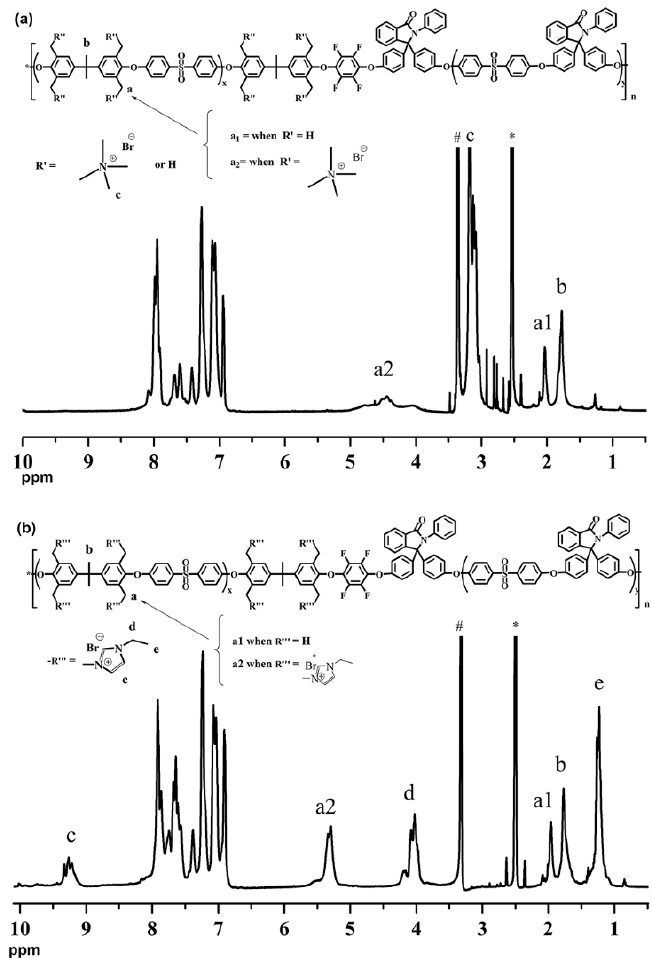
Figure 3. 1 H NMR spectra of ( a ) cardo-PES-QA and ( b ) cardo-PES-IM in DMSO-d 6 at 25 ◦ C. * indi- cates solvent peak and # indicates moisture